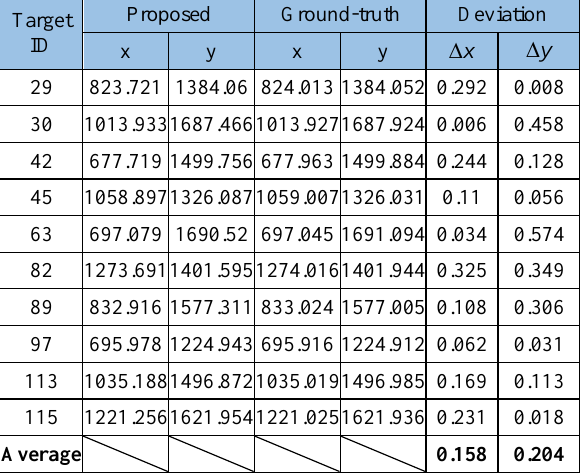
Table 6. Deviation analysis of feature points localization (pixel)